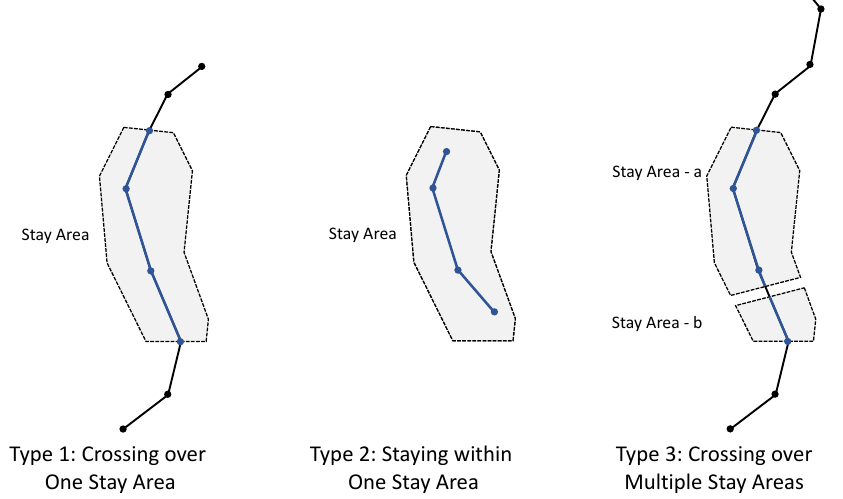
Figure 3. The three types of trajectories. Trajectories within a stay area refer to trajectories that are all contained in one stay area; trajectories through one cluster are those trajectories that pass through only one stay cluster and whose length within the stay area is less than 50% of the area’s total length; and trajectories through multiple clusters are defined as trajectories that pass through multiple stay clusters.